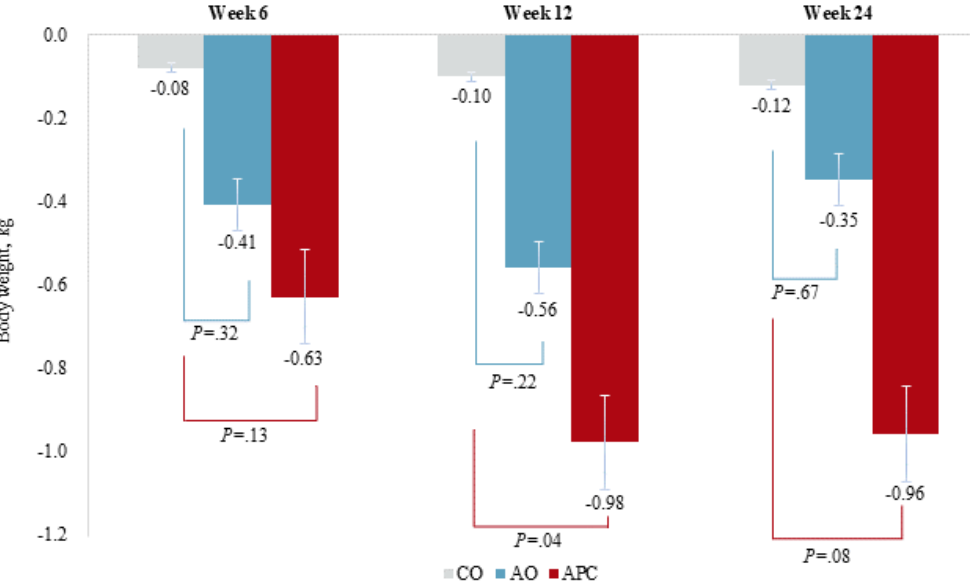
Figure 4. Body weight changes from the baseline across the 3 groups at each time point. AO: app-only; APC: app with personalized coaching; CO: control, SBP: systolic blood pressure.